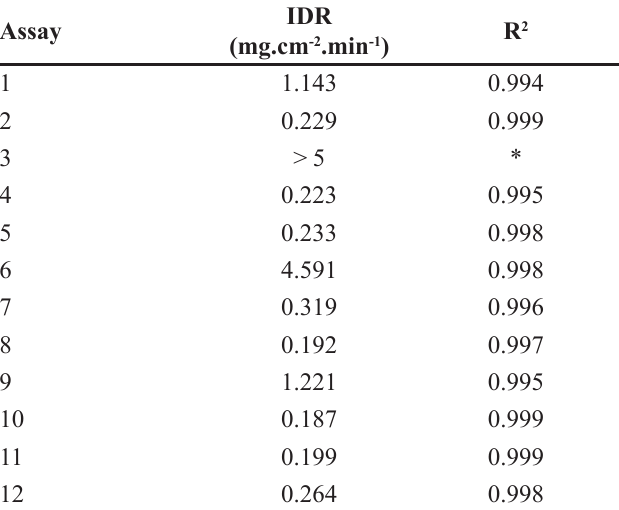
* Regression coefficient not obtained due to detachment of the compressed drug in the beginning of the test.